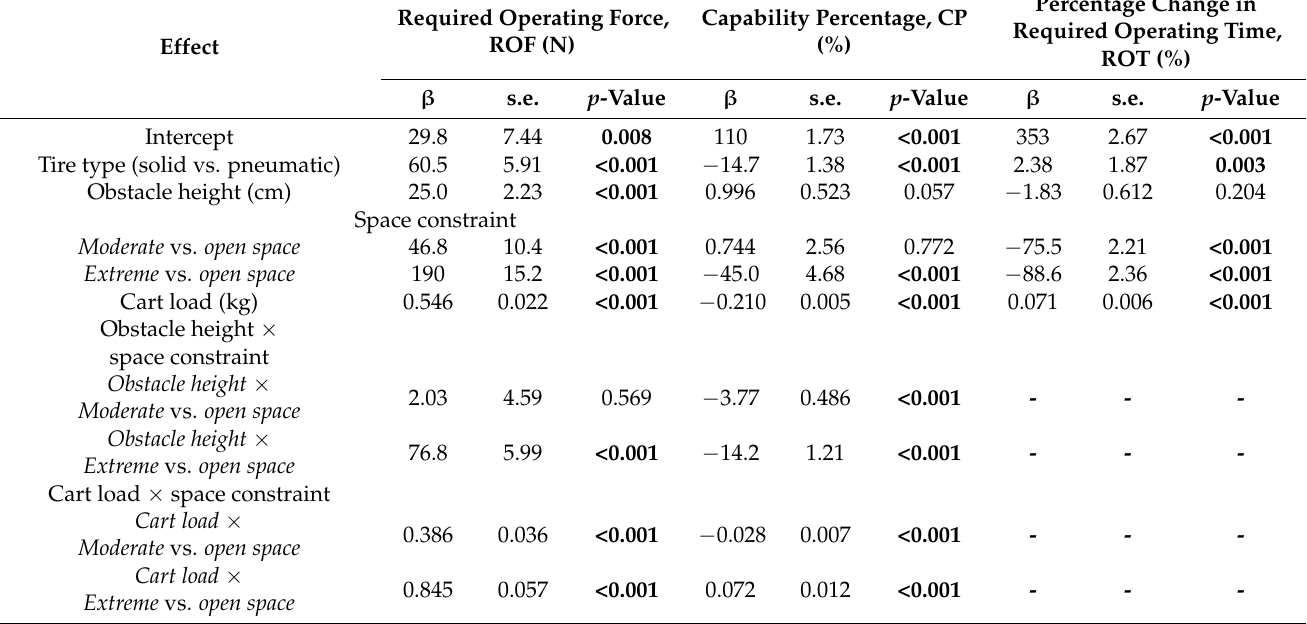
Table 4. Statistical results of Experiment 2a: Regression coefficients ( β ), robust standard errors (s.e.), and p -values from the final models, featuring four independent variables: tire type (pneumatic tire as baseline), obstacle height (1.9 cm as baseline), space constraint (open space as baseline), and cart load (16 kg as baseline), interaction terms between the obstacle height and space constraint and between the cart load and space constraint, and finally dependent variables (ROF, CP, and ROT). Bold fonts indicate p -values are less than our significance level 0.05.